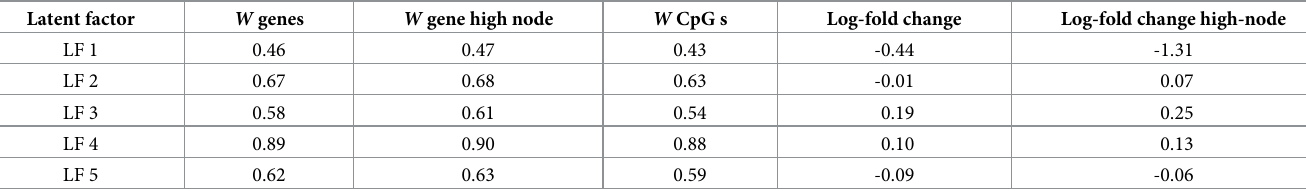
Table contains the average W coefficients for gene and CpG features and for gene features with high node degree. As can be seen from the table, the W coefficient for genes is higher than CpG features, even though the cumulative W is high for CpG sites. Also, the cumulative log fold-change for the selected features per latent factor is summarised in the table. The cumulative log fold-change for the gene features with high node degree is also